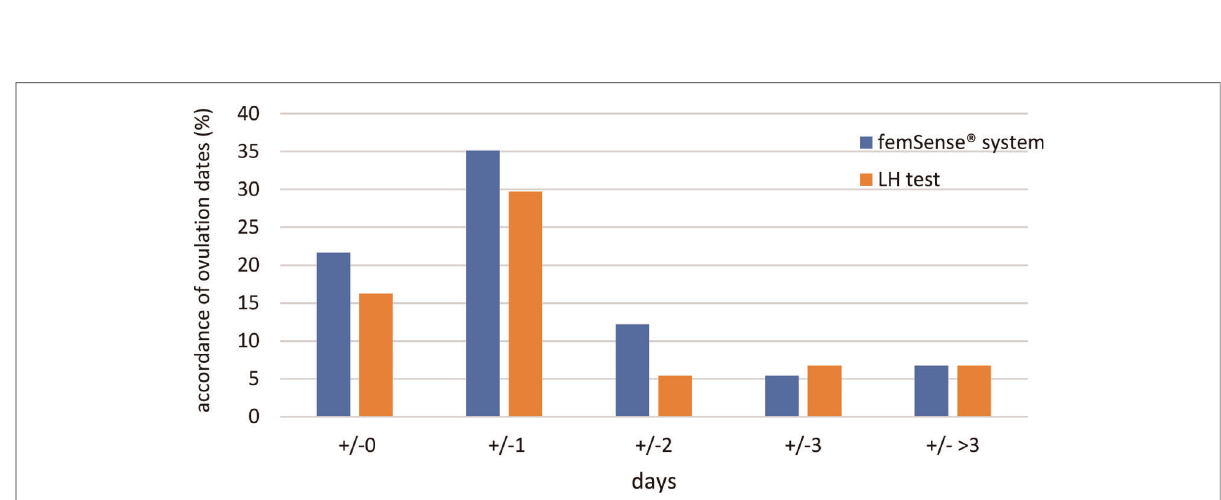
FIGURE 3 Overview of ovulation detection, con fi rmation, and prediction: the femSense ® system con fi rmed the ovulation in 60 participants while the LH test predicted ovulation in 48 participants. Signi fi cant differences are indicated as follows: * p <0.05; *** p <0.001.